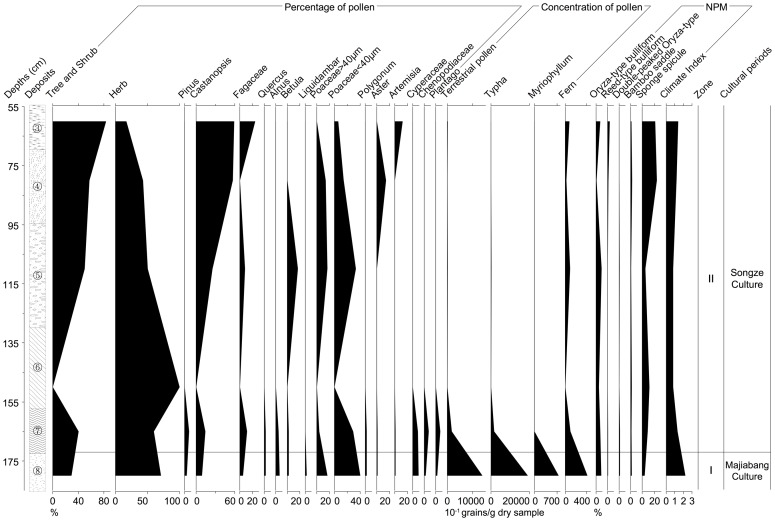
Integrated paleoecological data of P02 from the Jiangli site.